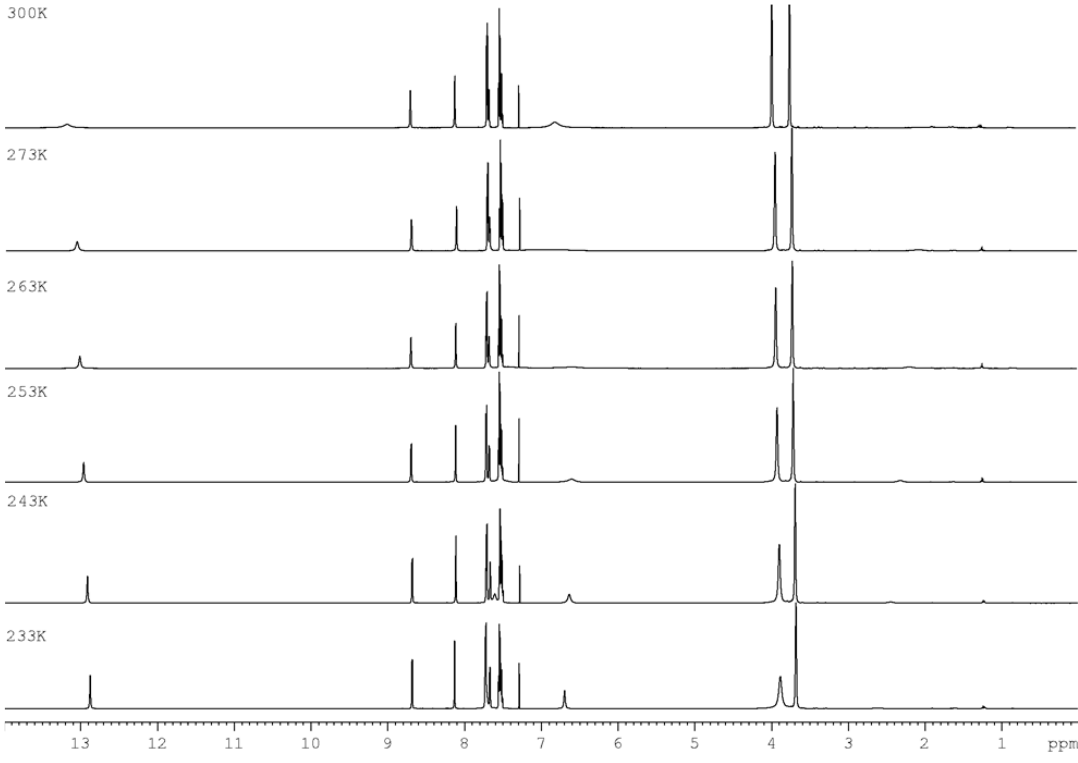
Figure 4. 1 H NMR spectra of 1b as a function of temperature (700 MHz, CDCl 3 ).